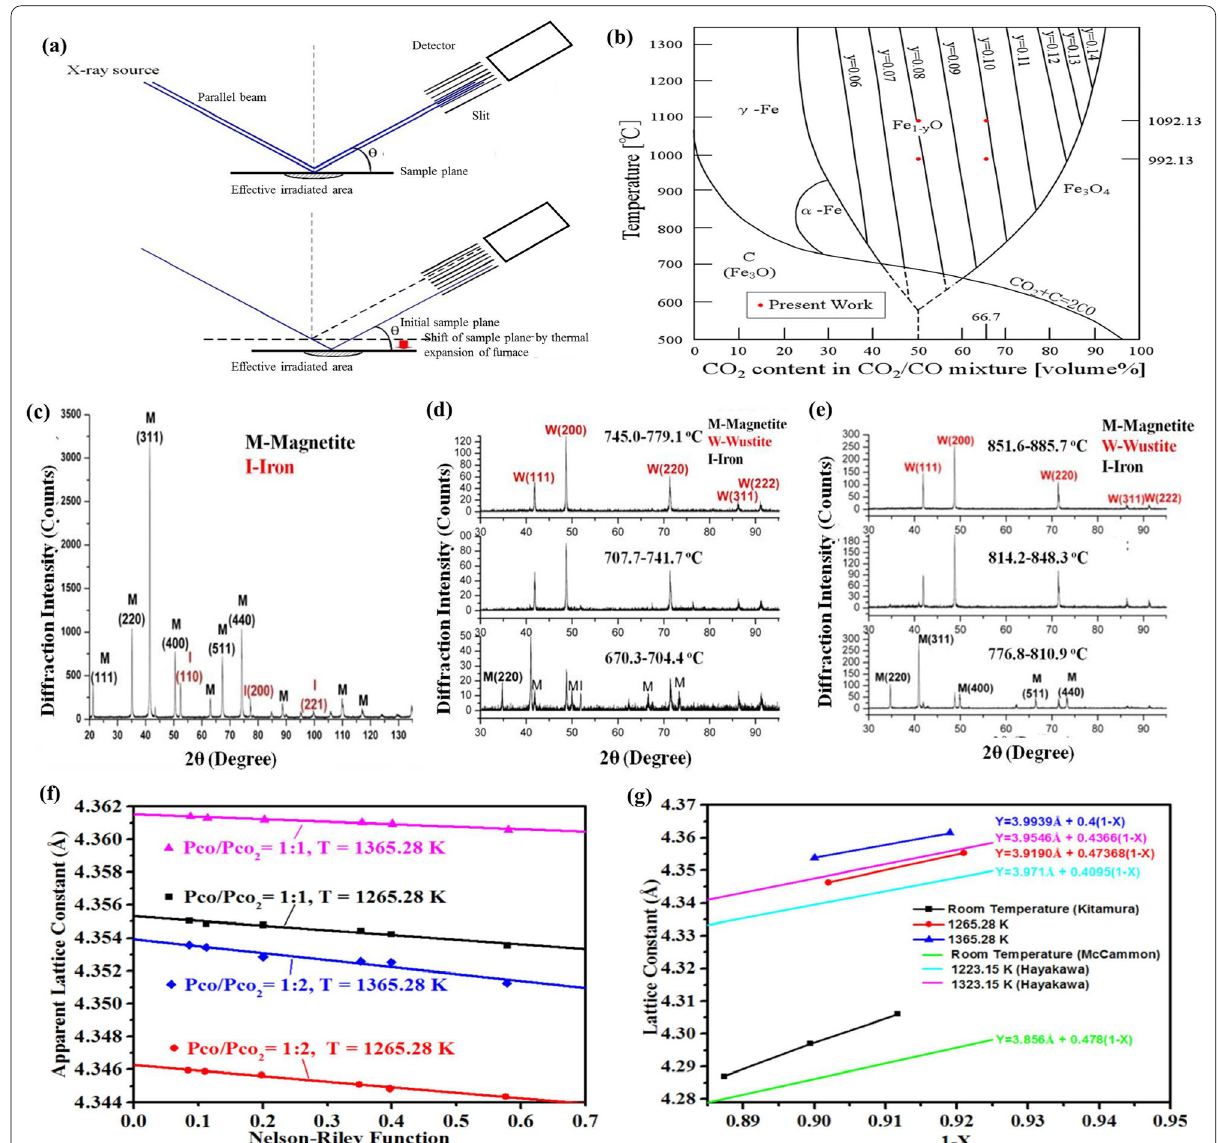
Fig. 2 a Schematic diagram of in-situ XRD. b Equilibrium between Fe, Fe 1 d XRD pattern of the sample synthesized at Pco/Pco